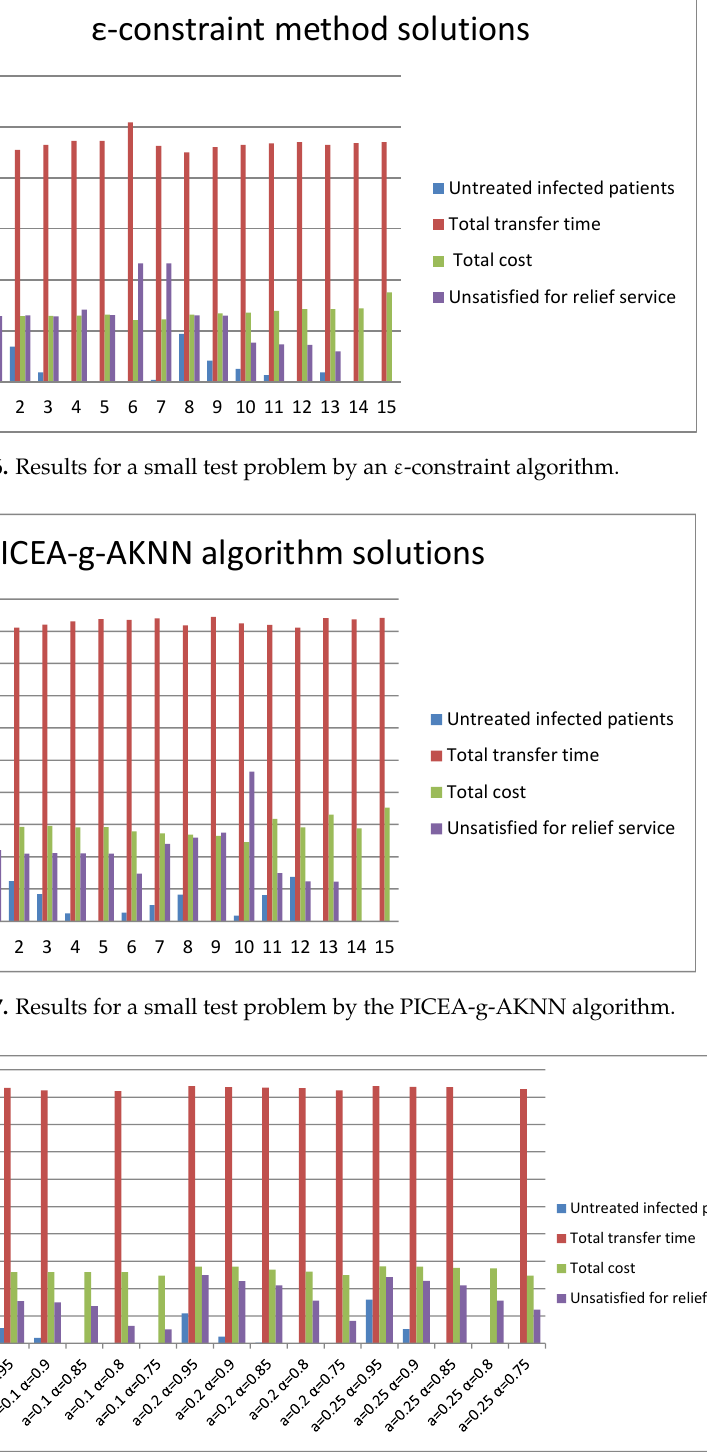
Figure 8. Results in different uncertainty parameters.